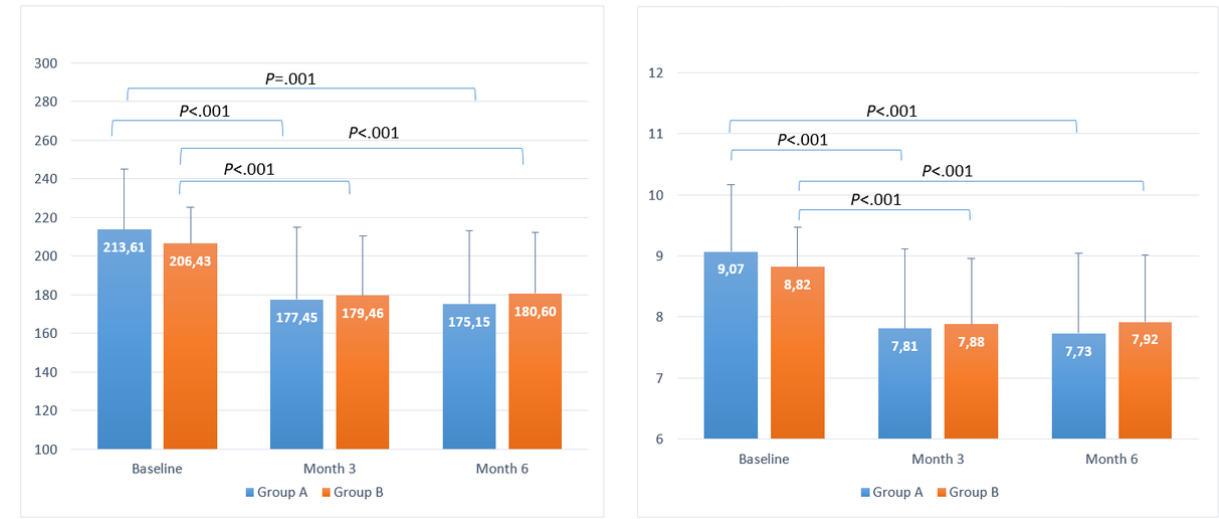
Figure 2. Timeline evolution of estimated blood glucose (left) and estimated glycated hemoglobin (right) for users with type 1 diabetes mellitus.